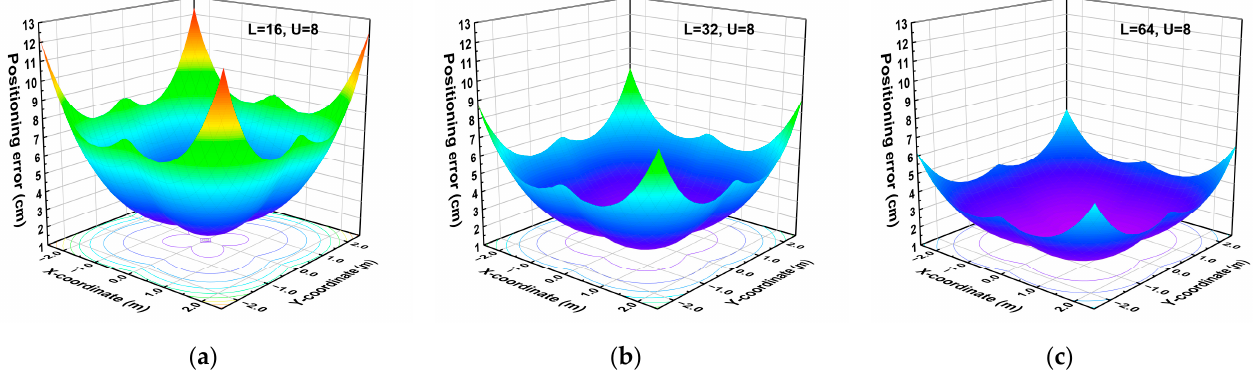
Figure 8. Surface diagram of positioning error estimated at all testing points of the 8-user VLCP system when the length of spreading code is ( a )16, ( b ) 32, and ( c ) 64.